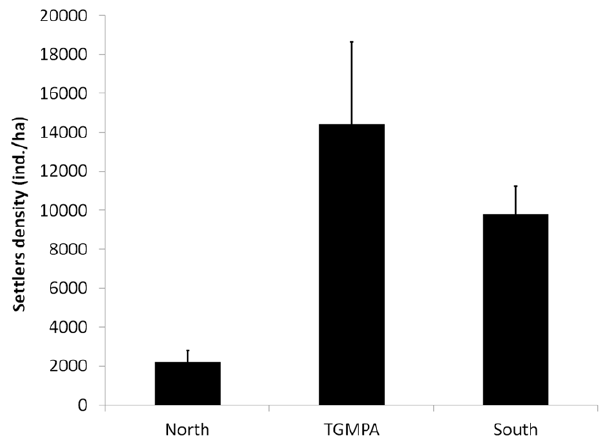
Figure 4. Mean density ( ± SE) of settlers of white sea bream assessed at the three Geographic Areas.